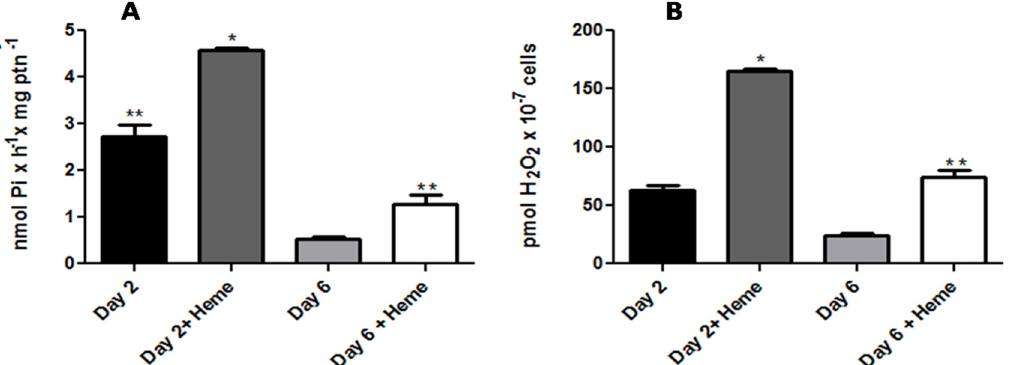
Fig 5. Hydrogen peroxide production and Na + /K + ATPase activation promoted by heme in L . amazonensis at log and stationary phases. Living parasites on the second or sixth day of growth were incubated for 20 min in the reaction medium with or without the addition of 2.5 μ M heme, as indicated on the abscissa. Na + /K + ATPase activity (A) and hydrogen peroxide production (B) were determinated. The values represent the mean ± standard error of at least three independent experiments. * Statistically significant when compared to day 2. ** Statistically significant when compared to day 6 (P < 0.05).